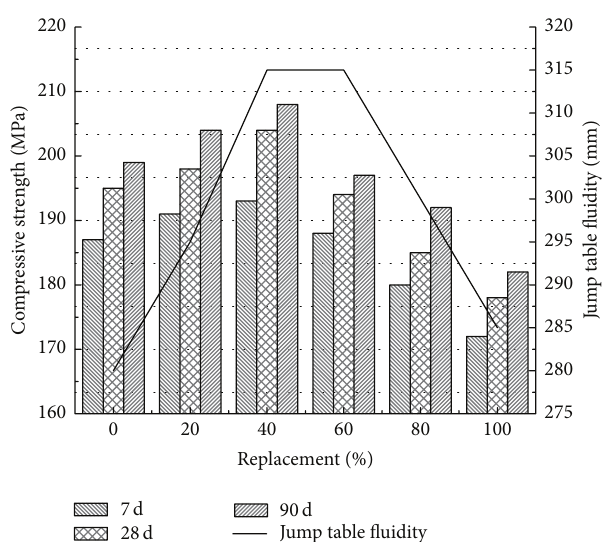
Figure 7: Influence of micropowder content on